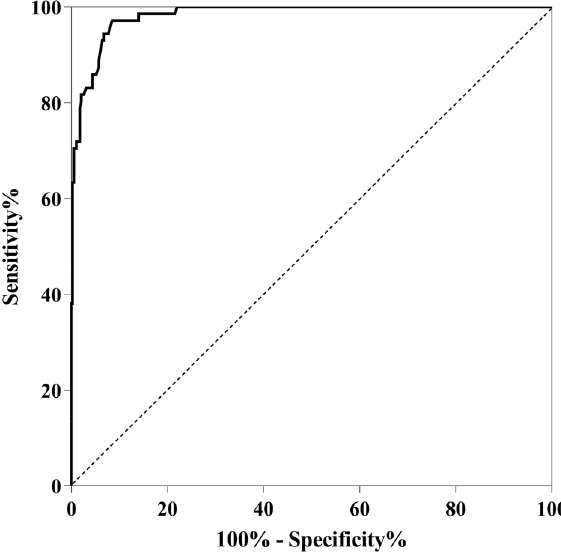
Figure 6. Nomogram scores were calculated for each patient in this study, and ROC curves were plotted (AUC = 0.983; 95% CI